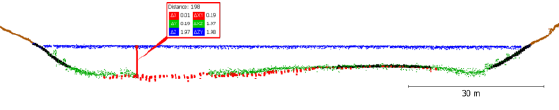
Figure 7: Example of a riverbed profile with water surface points (blue), water bottom points from standard data processing performed by the ALB data provider (black), additional points obtained from waveform stacking (green) and sonar reference measurements